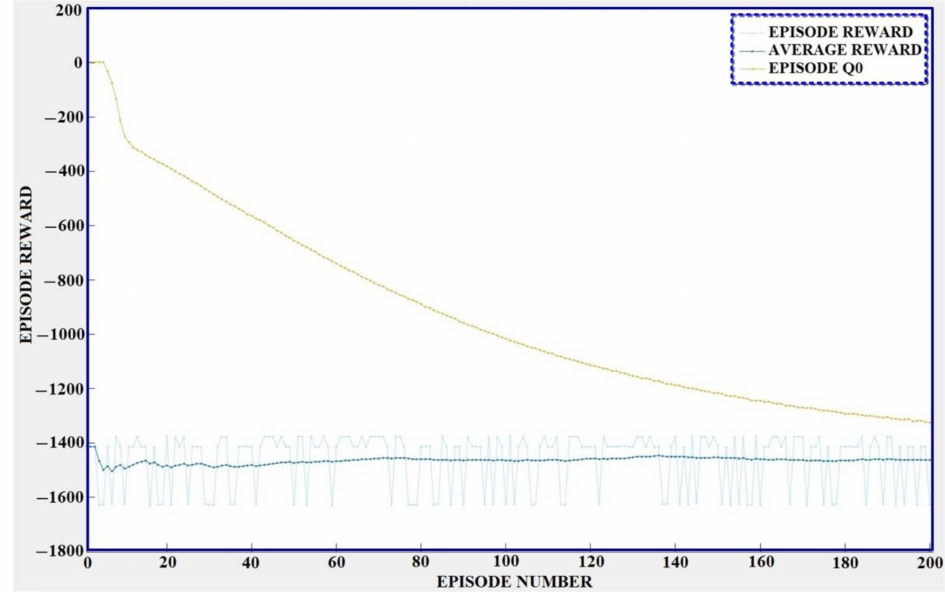
Figure 23. Training stage of the RL-TD3 agent for the correction of i qref